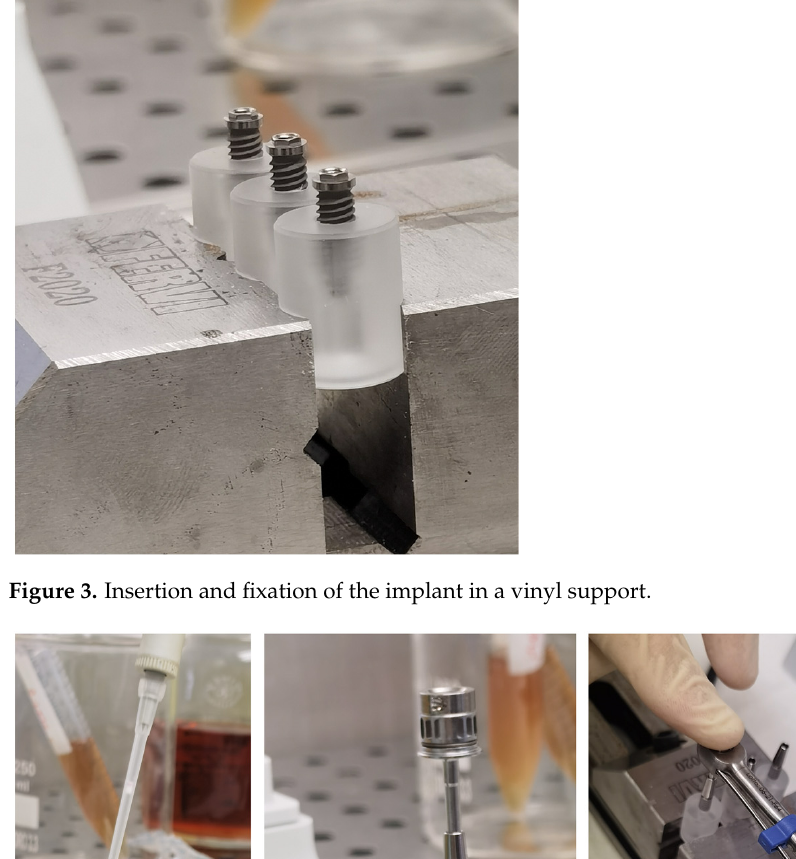
Figure 3. Insertion and fixation of the implant in a vinyl support.